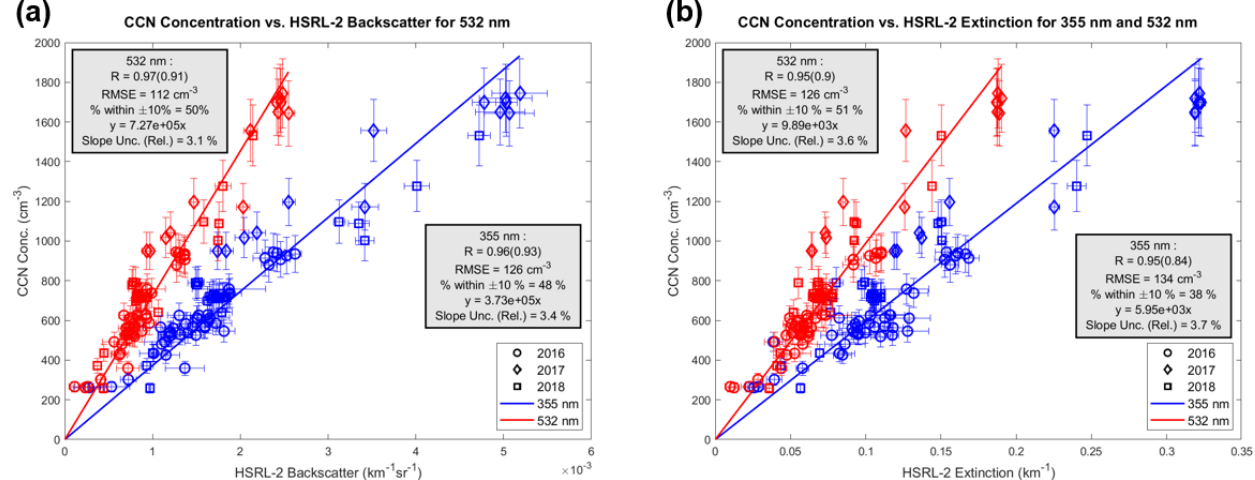
Figure 3. CCN concentration versus HSRL-2 (a) backscatter and (b) extinction coefficients with blue scatter points representing 355nm and red scatter points representing 532nm. This combined data set represents 10d of observations and 80 total collocated data points (per coefficient), covering all 3 years of ORACLES. Supersaturation for these observations ranges between 0.22%–0.4%. The Pearson correlation coefficient is shown, with the Spearman rank correlation coefficient given in parentheses. Error bars are given for a CCN relative uncertainty of 10% and for calculated HSRL-2 uncertainties. Lines of best fit are forced through the origin to represent the practicality of using linear regression equations to quantitatively obtain CCN concentrations using HSRL-2